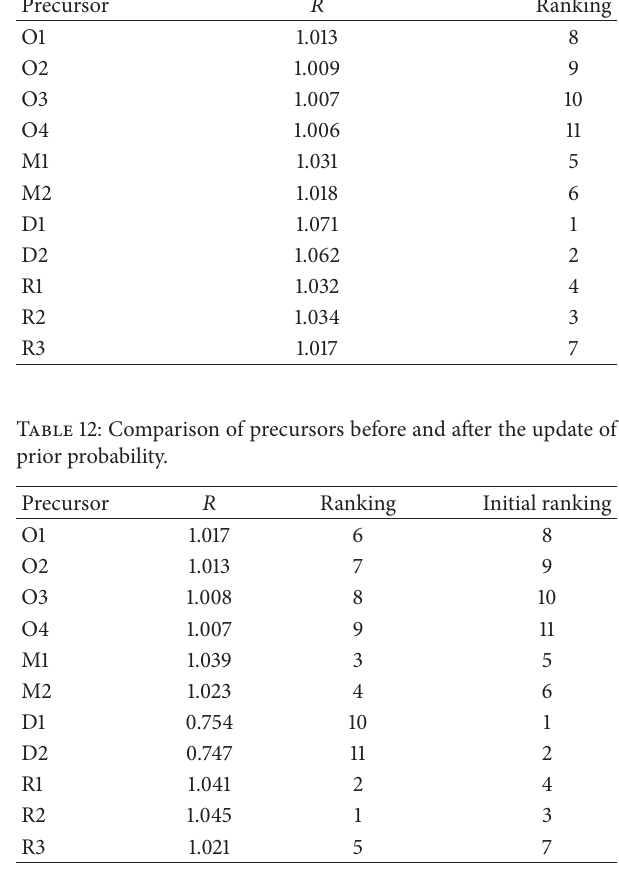
Table 11: Change of prior probability when the goal is high 100%. Precursor